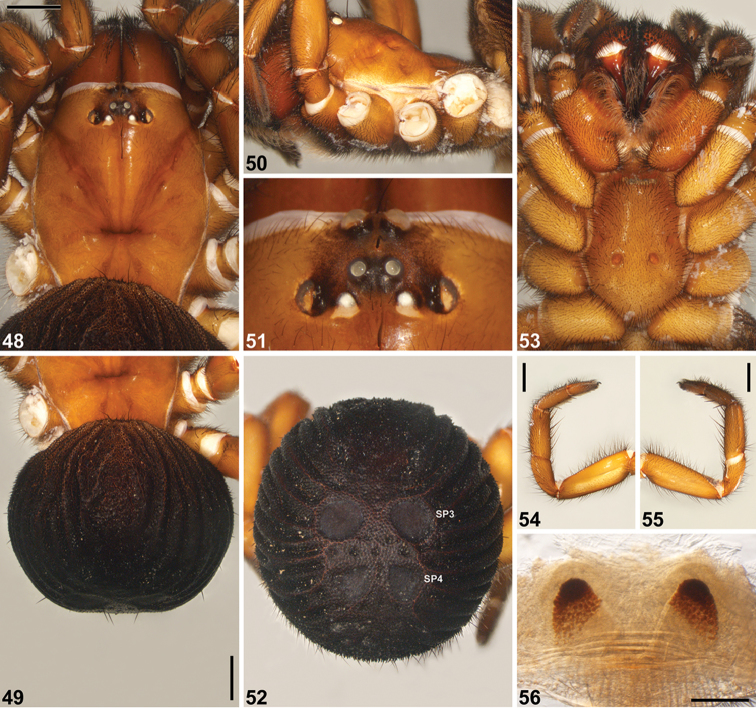

Idiosoma
nigrum Main, 1952, female (WAM T132737) from Minnivale Nature Reserve (Western Australia; AVW). 48–49 Carapace and abdomen, dorsal view 50 Carapace, lateral view 51 Eyes, dorsal view 52 Abdomen, posterior view 53 Sternum, ventral view 54 Leg I, prolateral view 55 Leg I, retrolateral view 56 Spermathecae, dorsal view. Scale bars 2.0 (48–49, 54–55), 0.5 (56). SP3–4 = sigilla pairs 3–4.